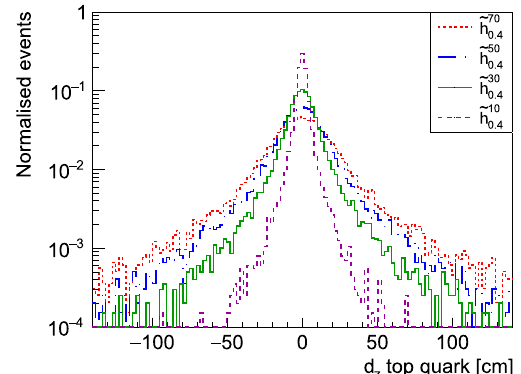
Fig. 32 Longitudinal impact parameter d z of the top quarks in the ˜ h 2 - = 400 GeV like case with m ˜ χ 0 1